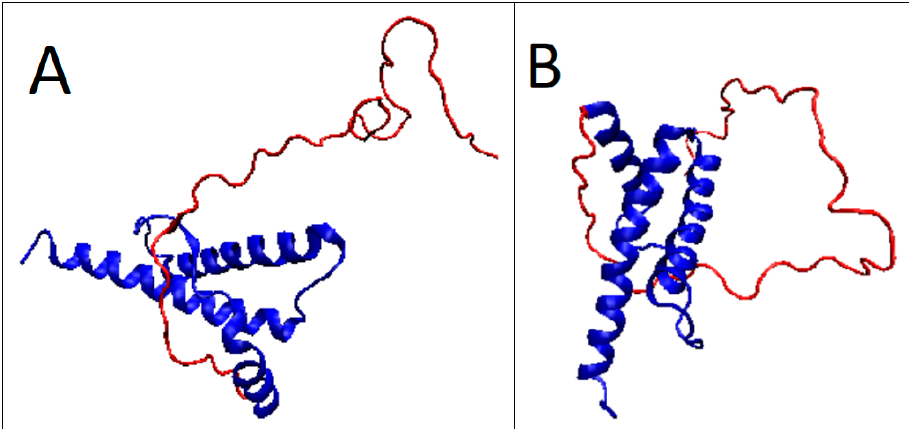
Figure 7. 3D presentation of the prion structure with a partially unfolded N-terminal fragment of the chain: ( A ) 5YJ5; ( B ) 5YJ4. The unstructured sections—in red.